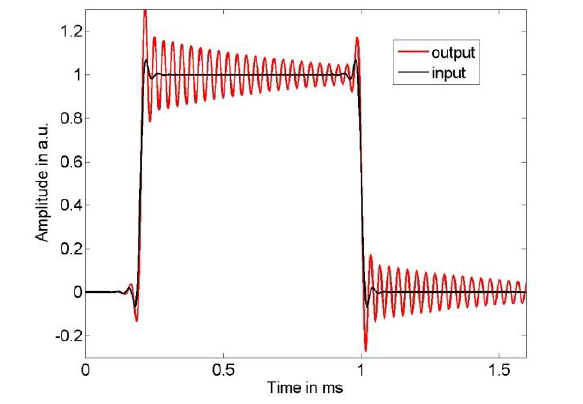
Figure 3. Broad-banded sensor input signal and resulting sensor output signal.